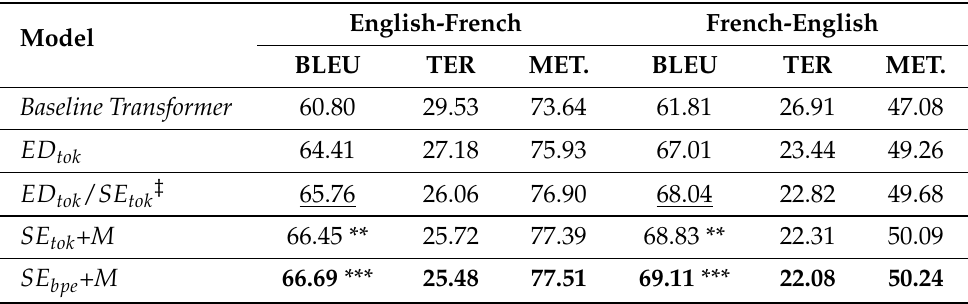
Table 7. Results for English ↔ French. Statistical significance of the improvements in BLEU are tested against the strongest baseline scores, which are underlined (**: p < 0.01; ***: p < 0.001). Best scores for the tested systems are highlighted in bold.